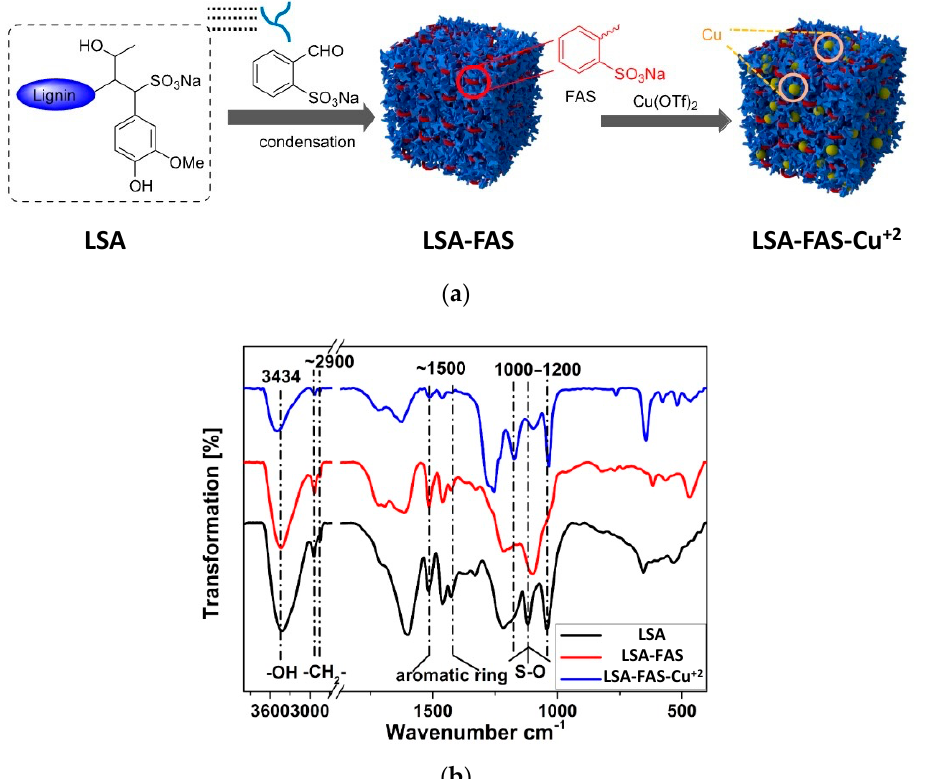
Figure 4. ( a ) Scheme for the preparation of LSA-FAS and LSA-FAS-Cu 2+ catalysts. ( b ) FTIR spectra of LSA , LSA-FAS , and LSA-FAS-Cu 2+ . Adapted with permission from reference [31]. Copyright 2014 Atlanta Publishing House LLC.